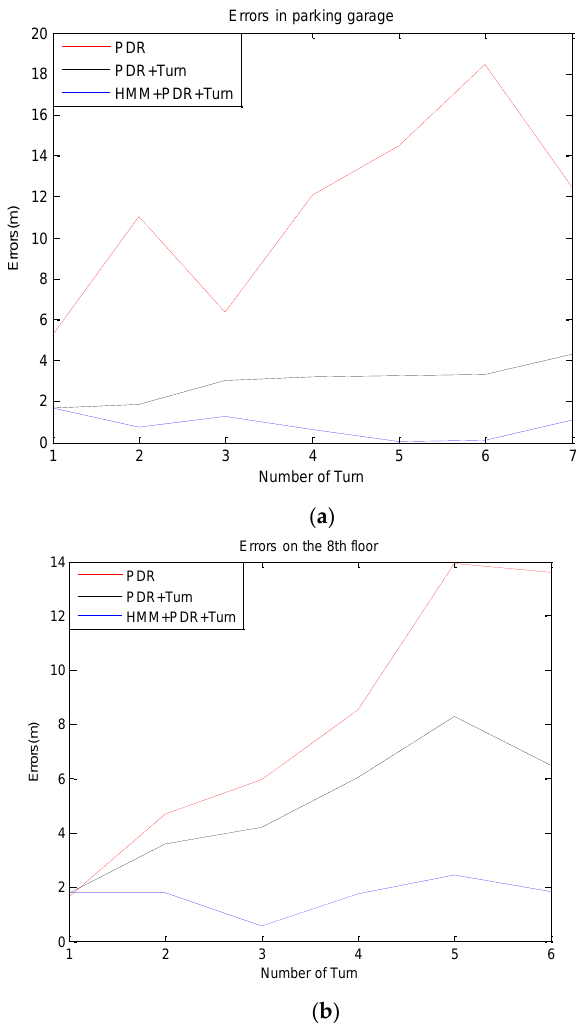
Figure 14. The comparison of positioning errors by different methods. ( a ) In parking garage; ( b ) on the 8th floor.